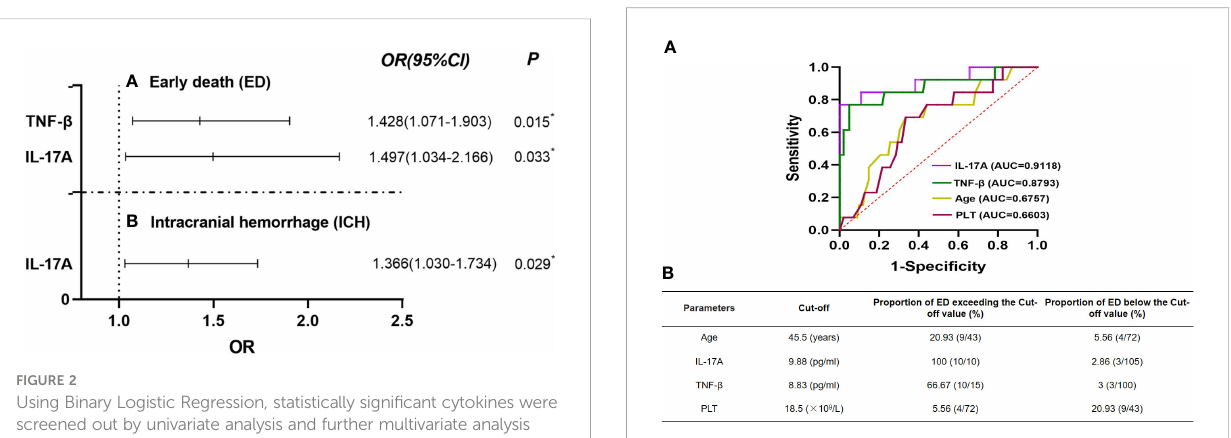
FIGURE 3 ROC curve of IL-17A, TNF- b and age in newly diagnosed APL patients with early death (A) . Cut-off values of them are determined by ROC curve (B) .